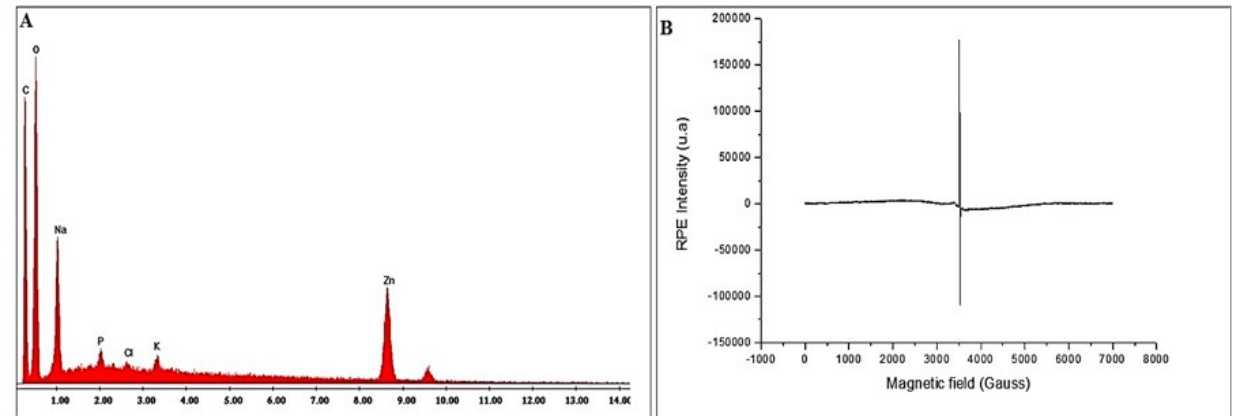
Figure 4. EDAX ( A ) and EPR ( B ) of C. siliqua bio-ZnONPs. Table 1. Determination of levels of Zn and other mineral elements in C. siliqua. bio-ZnONPs.